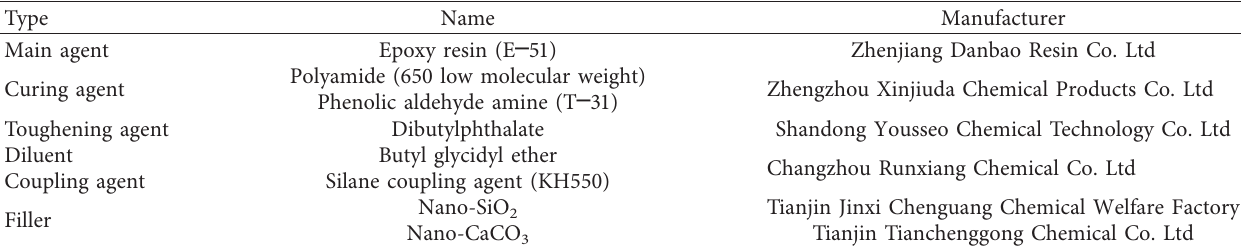
Table 1: Materials.